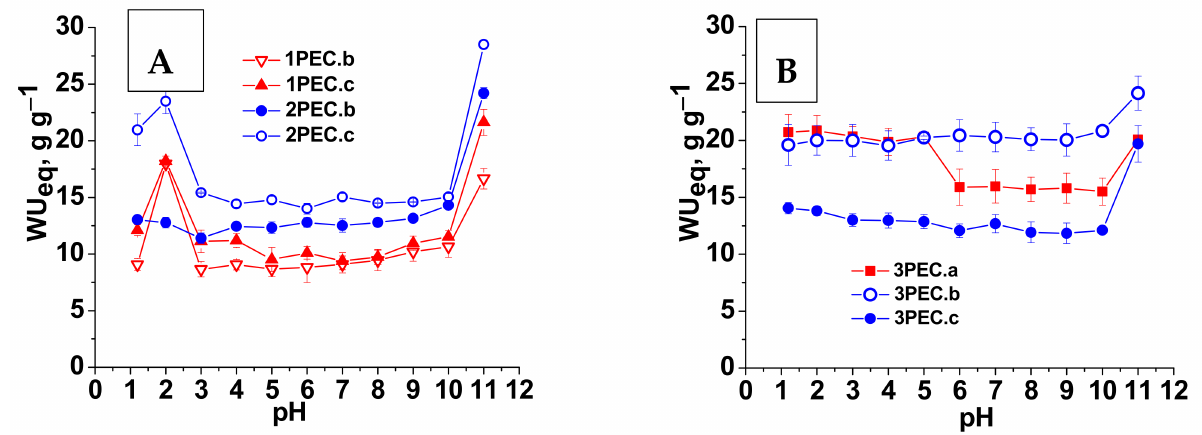
Figure 6. WU eq as a function of pH for PEC cryogels: ( A ) PECs with CMC as polyanion; ( B ) PECs with PAMPS as